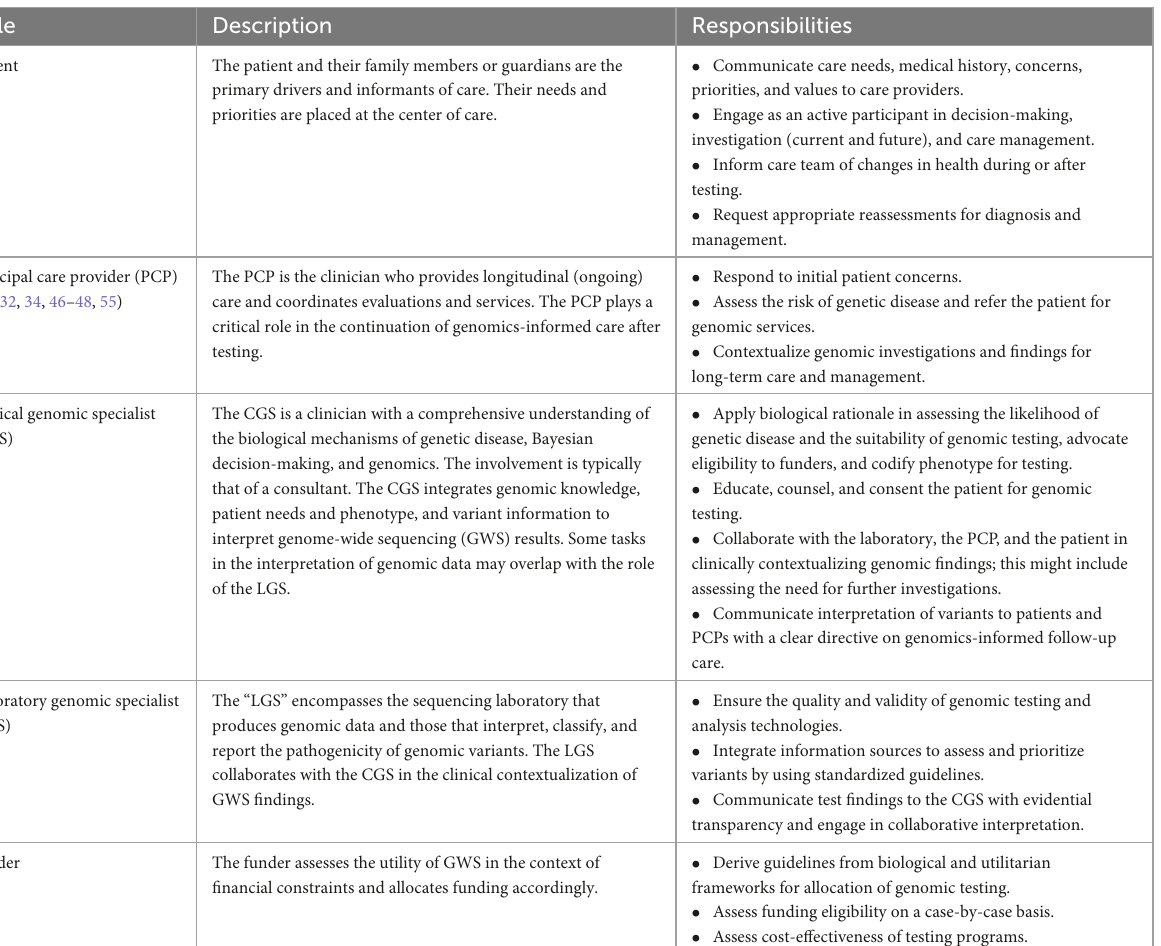
TABLE 1 Five key players in genomic